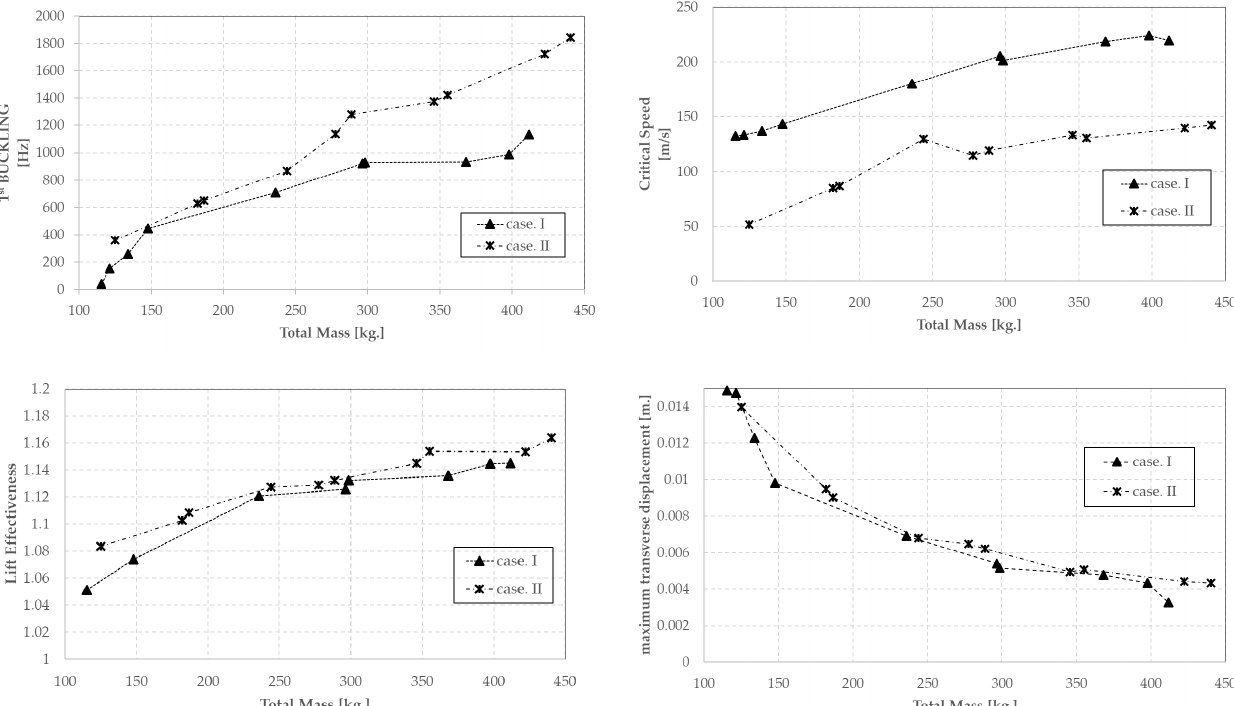
Figure 10. Comparison of the buckling, lift effectiveness, maximum transverse displacement, and critical speed in case. I vs. case. II.